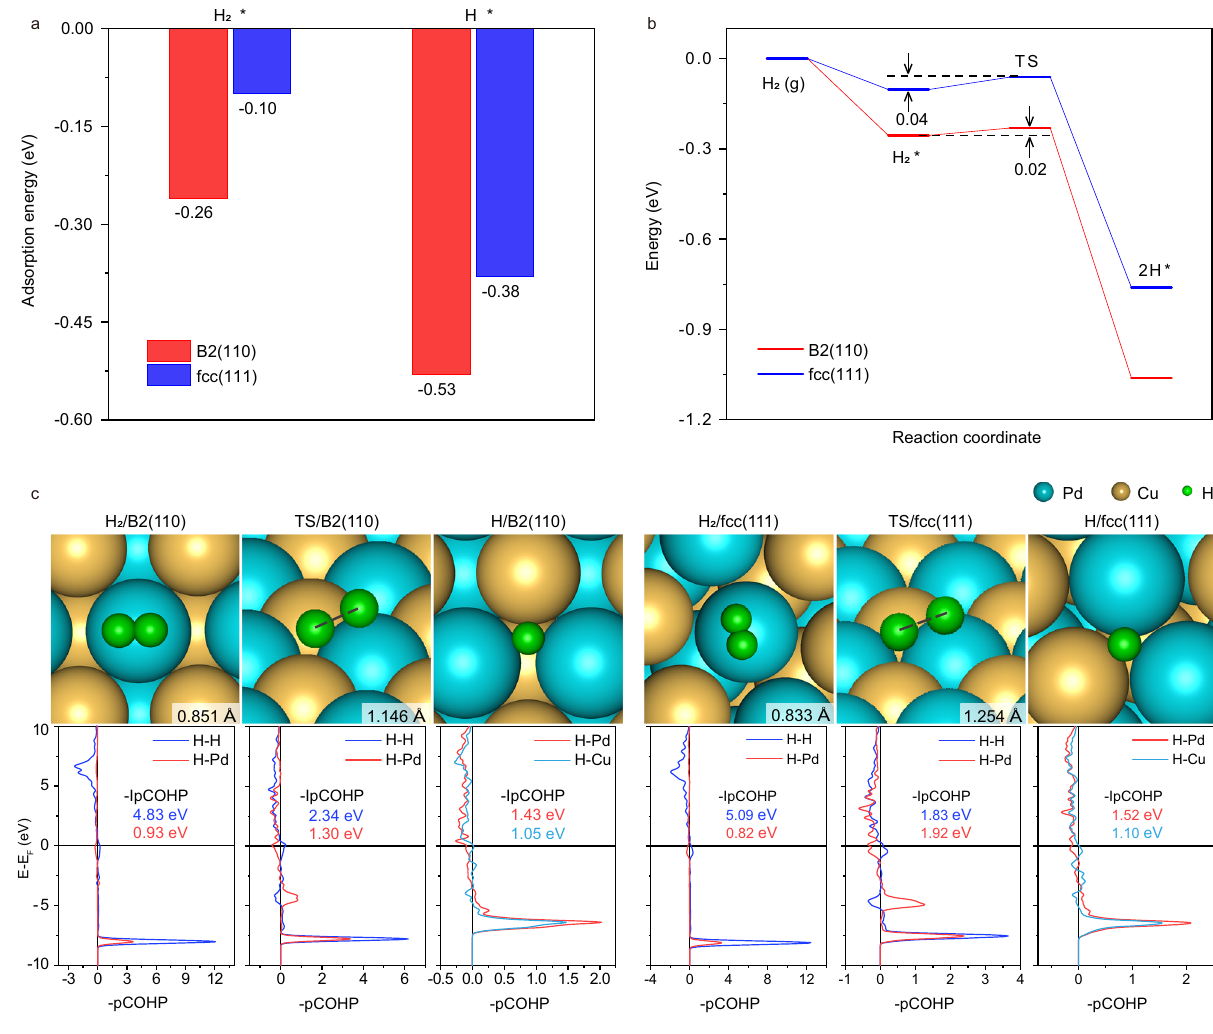
Fig. 6 | H 2 dissociation on the B2(110) and fcc(111) surfaces. a Adsorption ener- giesofH 2 andHatom; b Potential-energydiagramsofH 2 dissociation; c Geometric